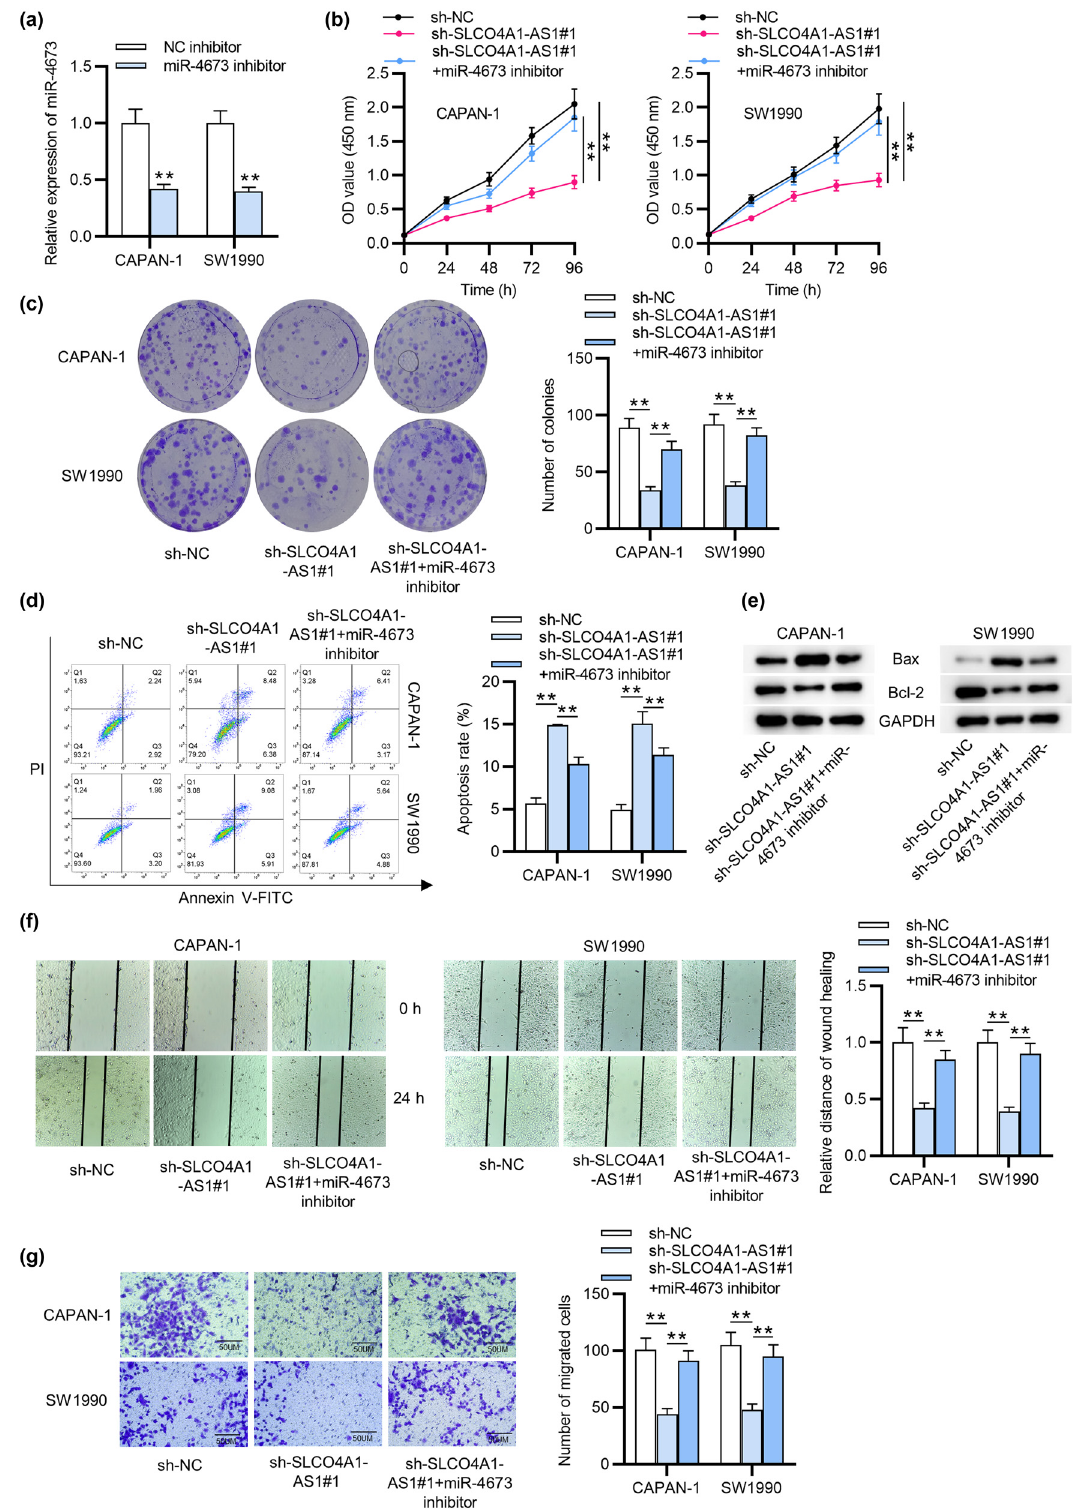
Figure 3: miR - 4673 inhibition reverses SLCO4A1 - AS1 knockdown - induced suppressive e ff ects on the phenotypes of PC cells. ( a ) qRT - PCR analysis for detecting the transfection e ffi ciency of miR - 4673 inhibitors in CAPAN - 1 and SW1990 cells. ( b ) The viabilities of CAPAN - 1 and SW1990 cells transfected with sh - NC, sh - SLCO4A1 - AS1#1, or sh - SLCO4A1 - AS1#1 + miR - 4673 inhibitors were analyzed by CCK - 8 assay. ( c ) Colony formation assay was used to examine the proliferation of PC cells with above transfection. ( d and e ) The apoptosis of transfected PC cells was assessed by fl ow cytometry and western blot analysis. ( f and g ) Wound healing and transwell assays were performed to evaluate the migration and invasion of PC cells with above transfection. All experiments were performed in triplicate. More images for replicates are provided in a supplementary fi le named Replicate images. ** p <